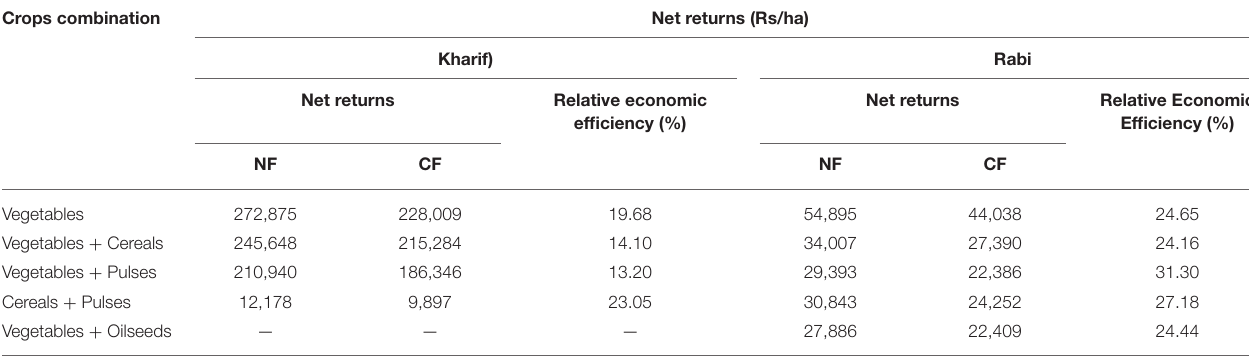
TABLE 17 | Crop combination-wise net returns under NF and CF systems. Crops combination